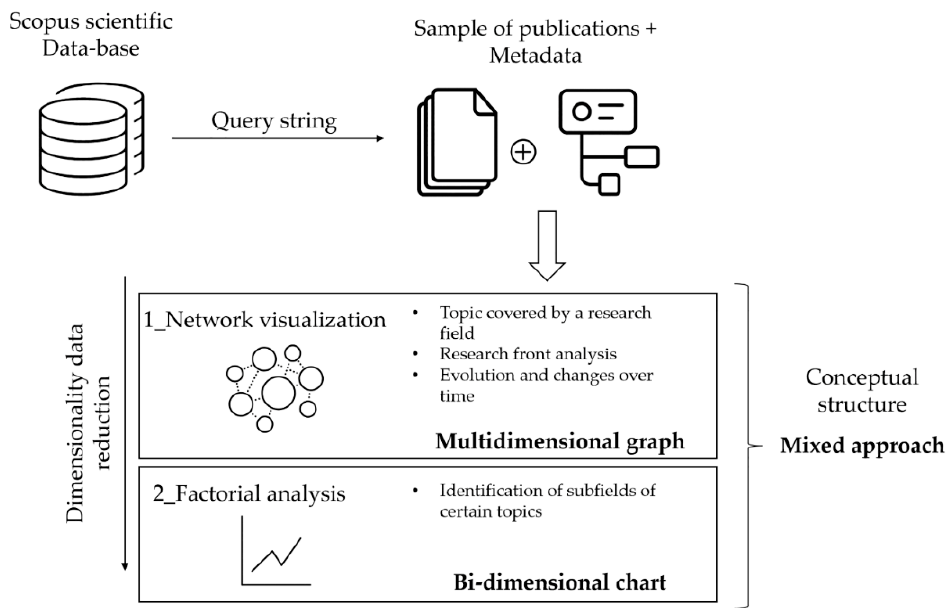
Figure 5. Conceptual analysis approach for the investigation of the research topic.